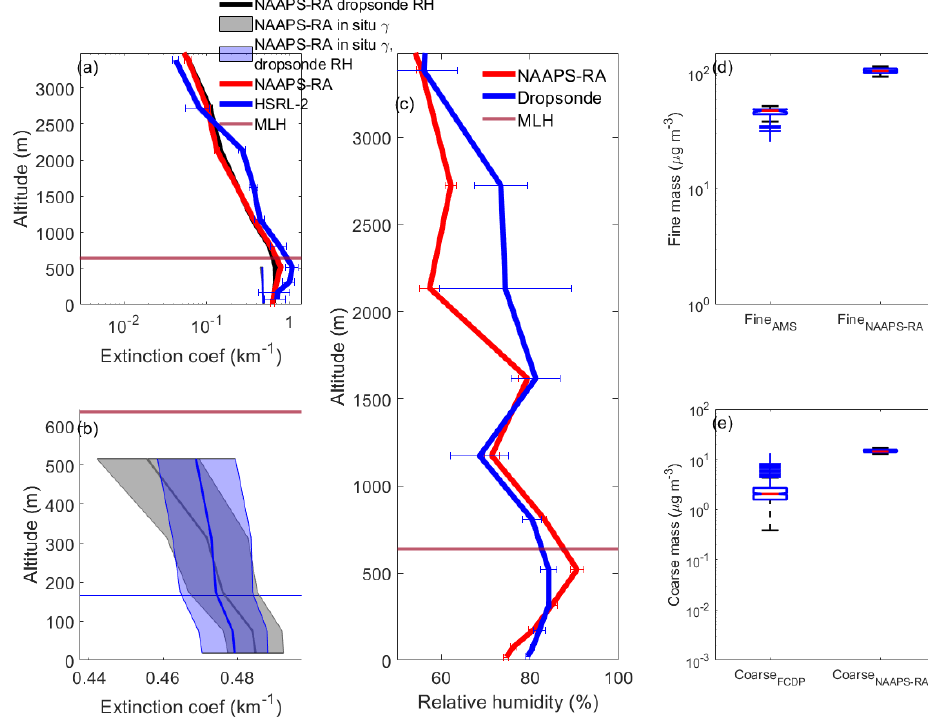
Figure 8. Same as Fig. 7 except for Case II (RF9) on 15 September 2019. The MLH is 638m.